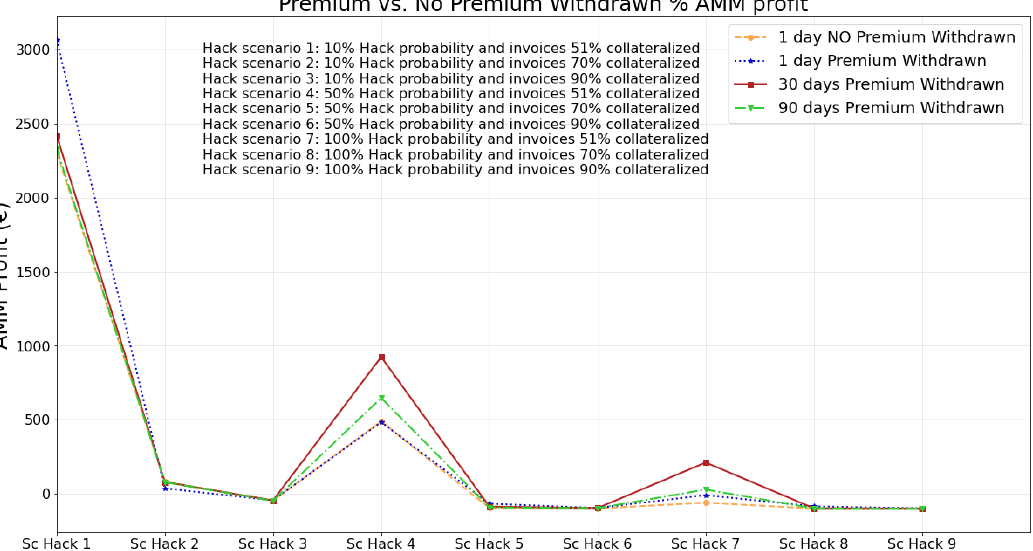
Figure 9. Premium vs. No Premium Withdrawn rkAMM profit absolute values from hack scenario.